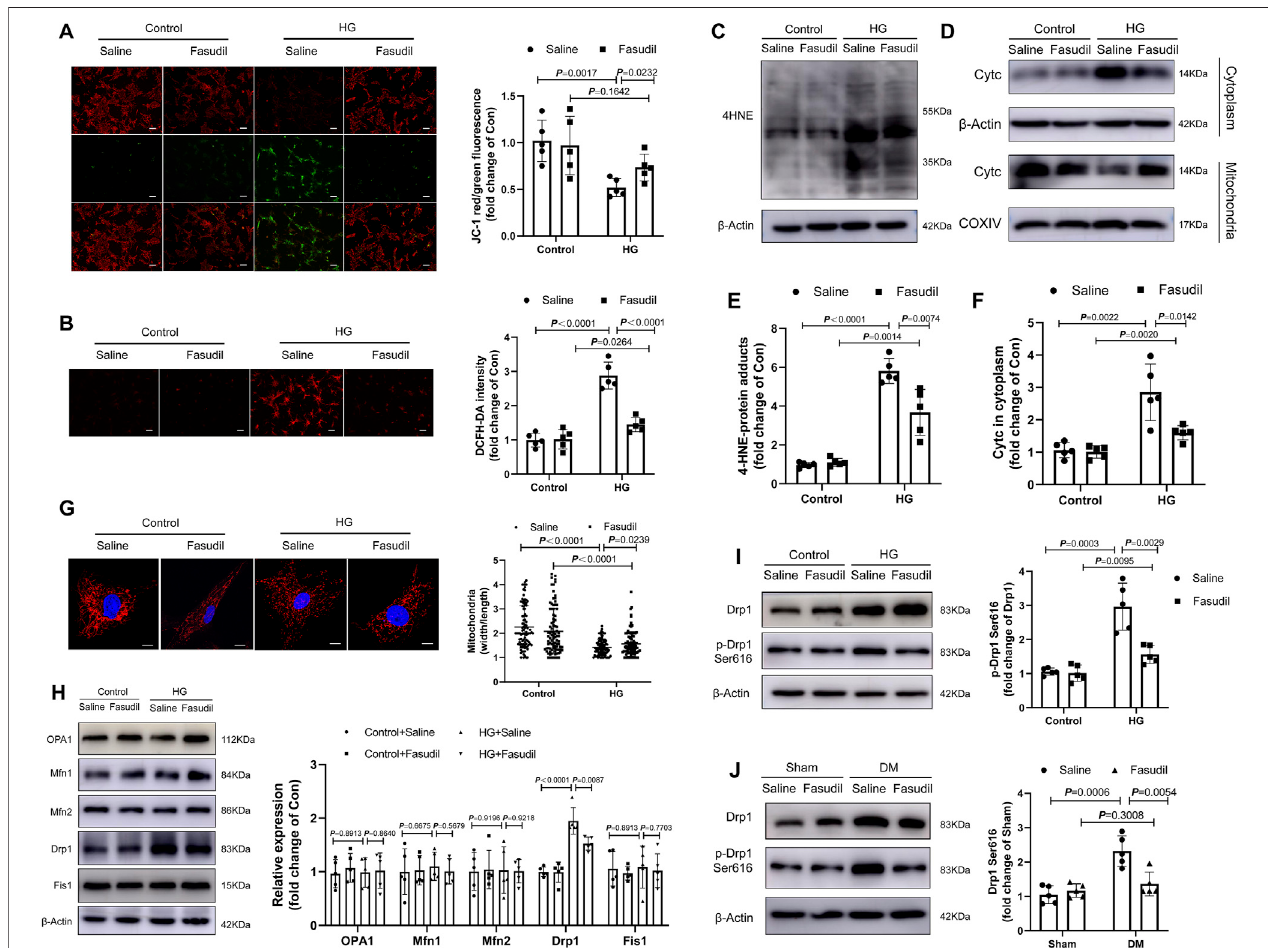
FIGURE6| Fasudilabrogatedmitochondrial fi ssionand superoxidegenerationinhyperglycemia-treatedcardiomyocytes (A) TheMMP wasmeasured using JC-1 staining. The histograms indicate the ratio of green and red fl uorescence (n = 5) (B) DCFH-DA staining and quantitative evaluation of ROS in NMCMs with HG treatment and Fasudil (10 μ M) treatment for 48 h (n = 5) (C,E) Immunoblotting and quantitative assessment of 4-HNE in NMCMs (n = 5) (D,F) Cytoplasmic Cytc protein levels, mitochondrial Cytc protein levels in NMCMs under 48 h periods of HG stimulation and Fasudil treatment (n = 5) (G) NMCMs were treated with HG (33 mM and 10 nmol/L insulin) and stained using Mitotracker Red and DAPI (n = 3). Confocal laser scanning fl uorescence microscope imaging of the mitochondrial morphology. Mitochondrial fi ssion was evaluated by the ratio of mitochondrial length and width, which was plotted for thousands of mitochondria from > 10 cells. Scale bar = 20 μ m (H) ImmunoblottingandquantitativeassessmentofOPA1,Mfn1,Mfn2,Drp1,Fis1inNMCMsunder48 hperiodsofHGstimulationandFasudiltreatment(n=5) (I) levels ofDrp1phosphorylatedatserine616inNMCMsunder48 hperiodsofHGstimulationandFasudiltreatment(n=5) (J) Representativeimmunoblotsandquanti fi cationof the levels of Drp1 phosphorylated at serine 616 in vivo (n = 5). p -values were adjusted for comparisons of multiple